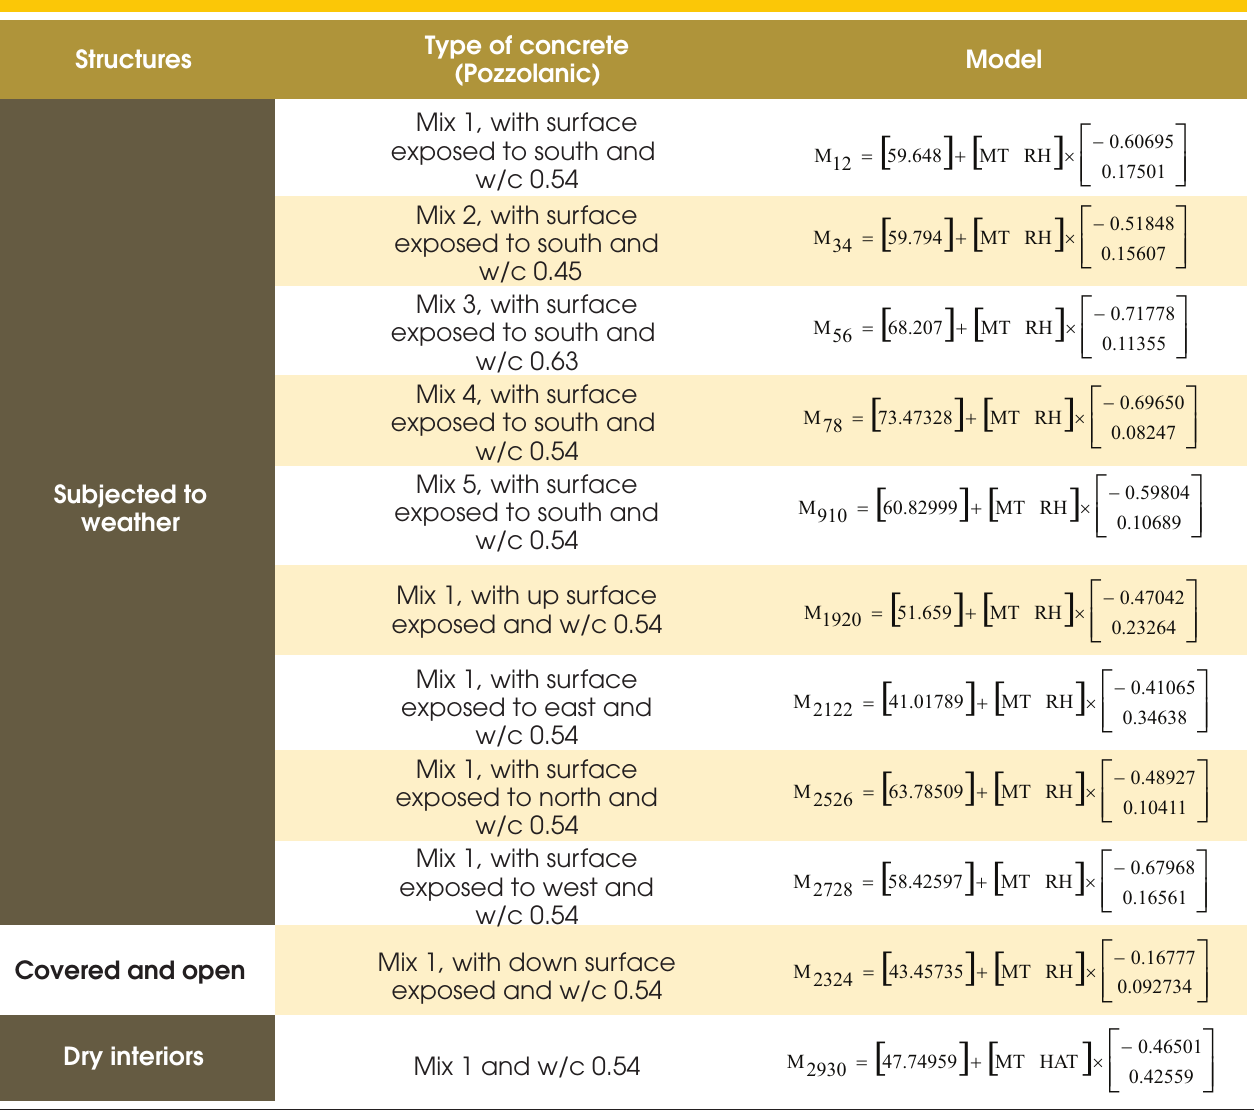
Table 9 – Guide of appropriate models for each type of